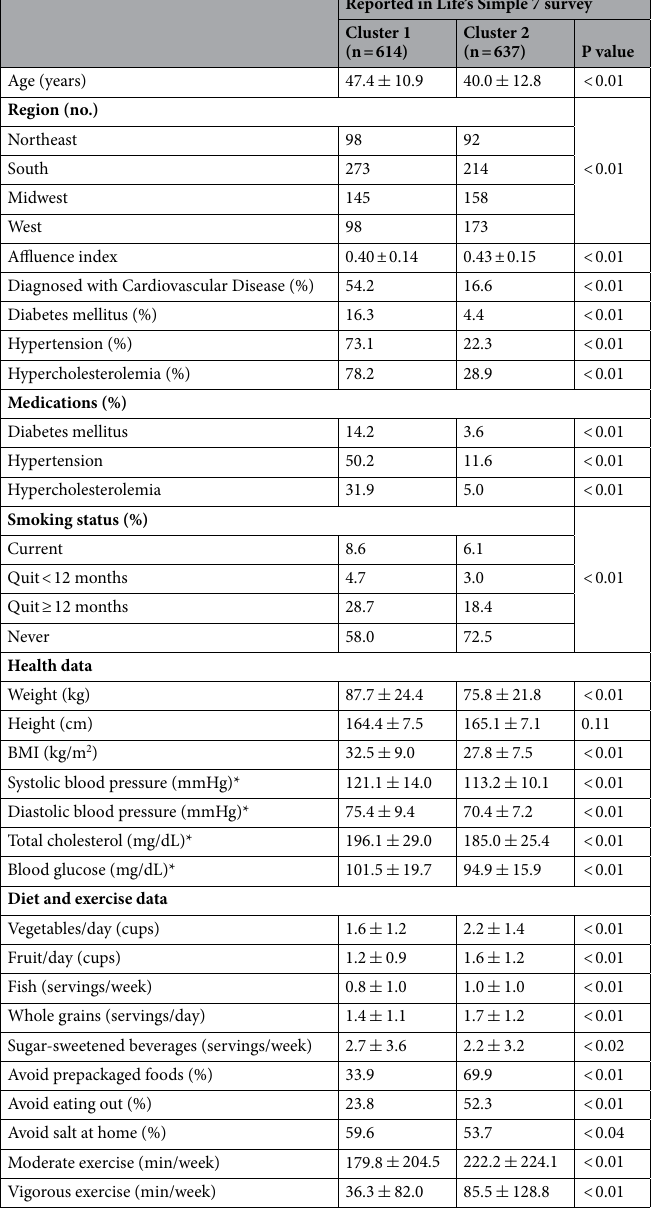
Table 3. Phenogroup self-reported Life’s Simple 7 data. *Contains data imputed from Life’s Simple 7. Categorical variables are analyzed by Chi-Square test. Continuous variables are analyzed by t-test. Non- parametric variables were analyzed by Wilcoxon rank-sum